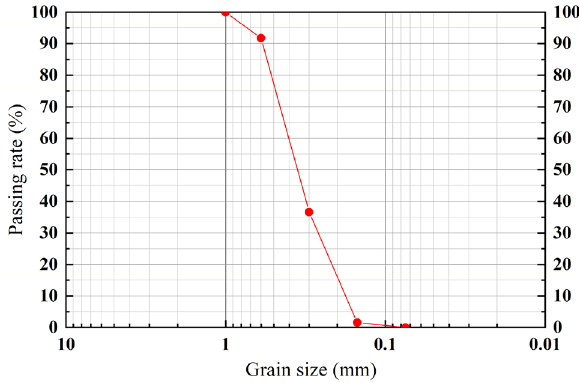
Figure 1. Grain size distribution curve of the tested